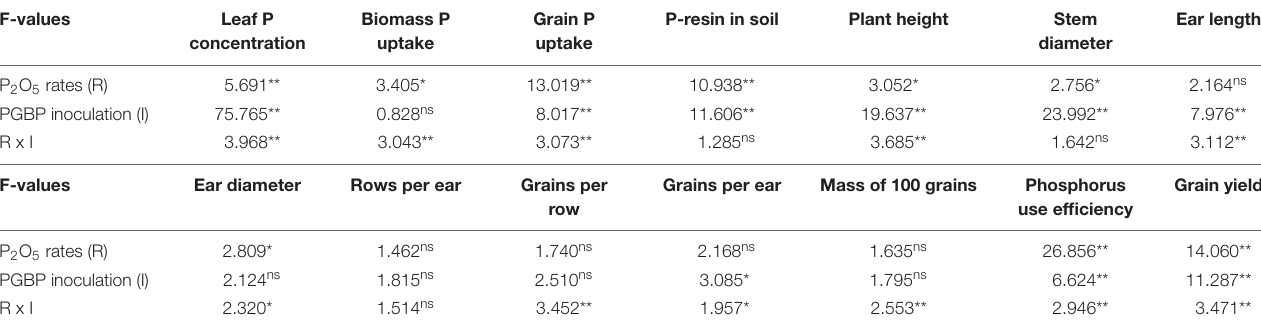
TABLE 2 | F-values for leaf P concentration, biomass P uptake, grain P uptake, P-resin in soil, plant height, stem diameter, ear length, ear diameter, number of rows per ear, grains per row and grains per ear, mass of 100 grains, phosphorus use efficiency and corn grain yield 2016/17. F-values Leaf P Biomass P concentration